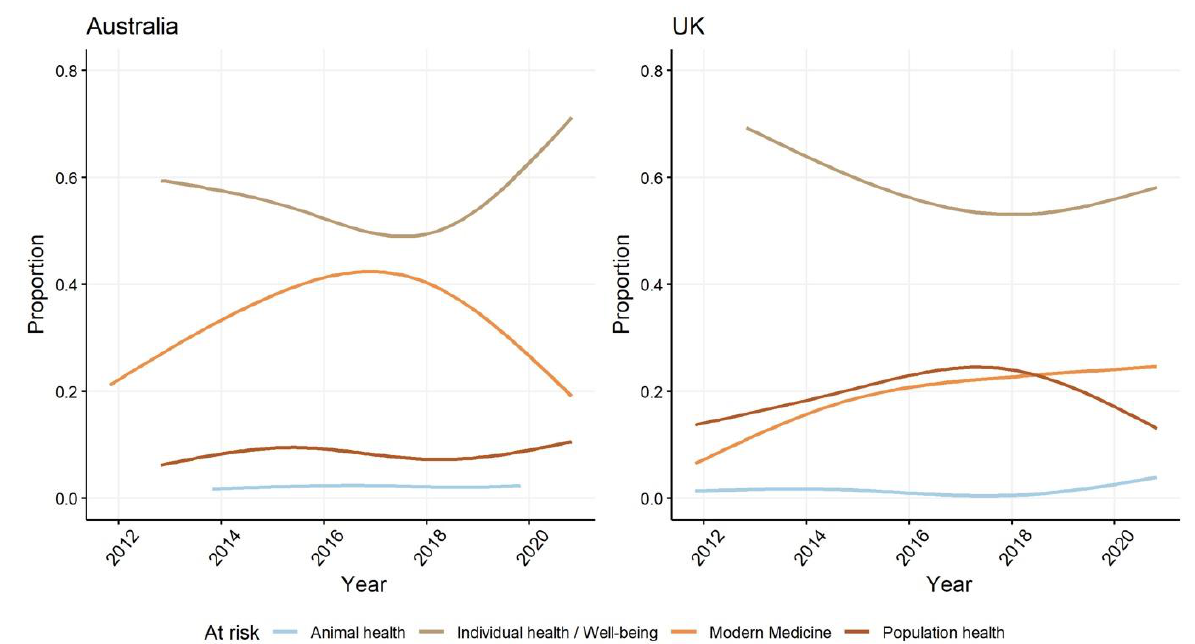
Figure 5. Proportion of different framings in Australian and UK newspapers of who and what is most at risk from AMR.